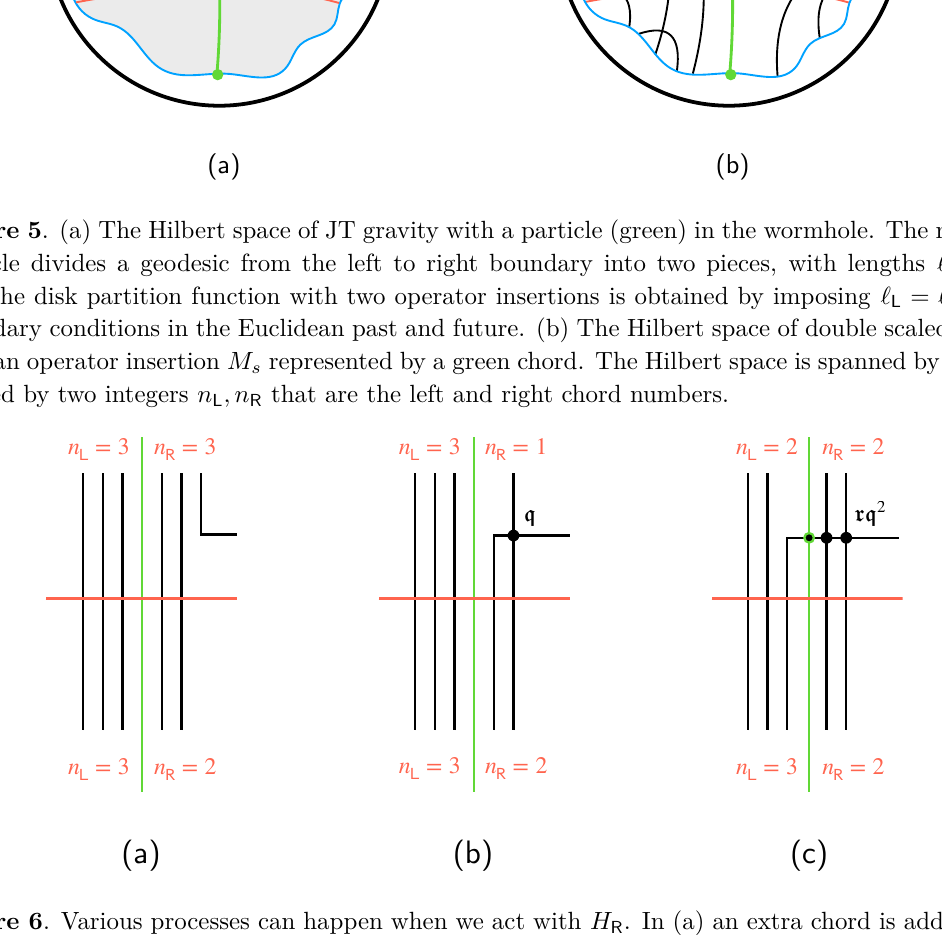
Figure 6 . Various processes can happen when we act with H R . In (a) an extra chord is added. In (b) a chord from the right is removed. In this example, it crosses a chord. In (c) a chord from the left is removed. It crosses the matter particle and all n R